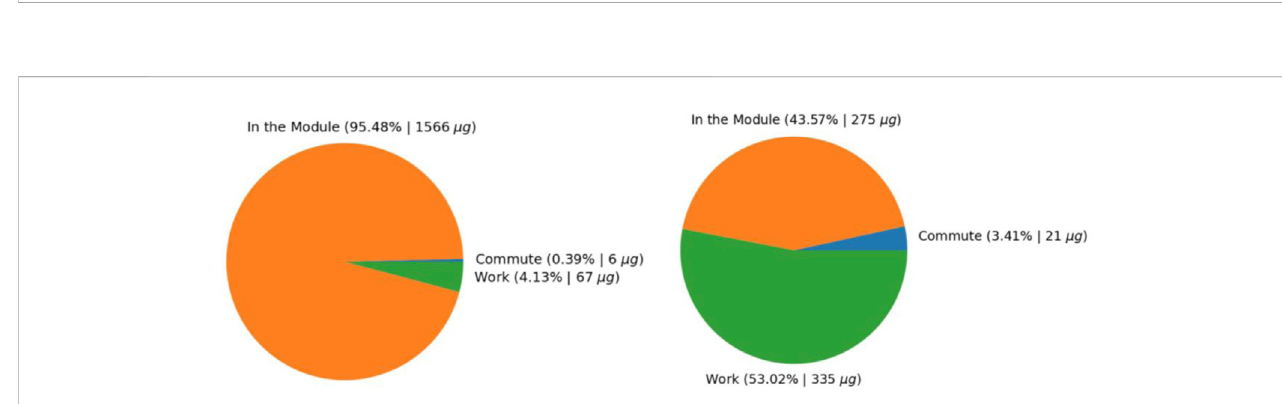
Frontiers in Built